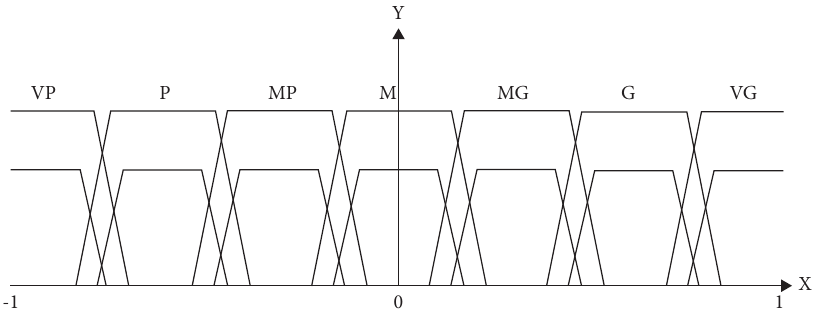
Figure 2: Te positive and negative restrictions for the extended IT2FVIKOR. Table 2: Linguistic scale of reliability for the extended